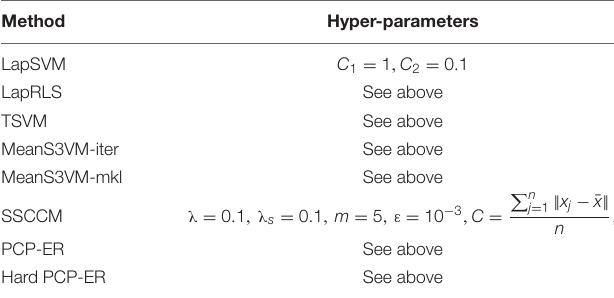
TABLE 4 | Performance about PCP-ER and the latest methods on DEAP